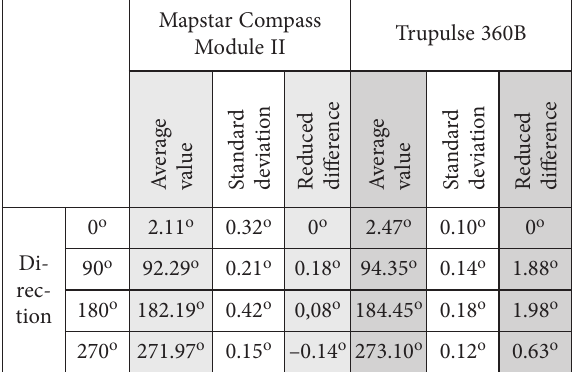
Table 2. Average values, standard deviations and reduced differences of obtained azimuths according to used device Mapstar Compass